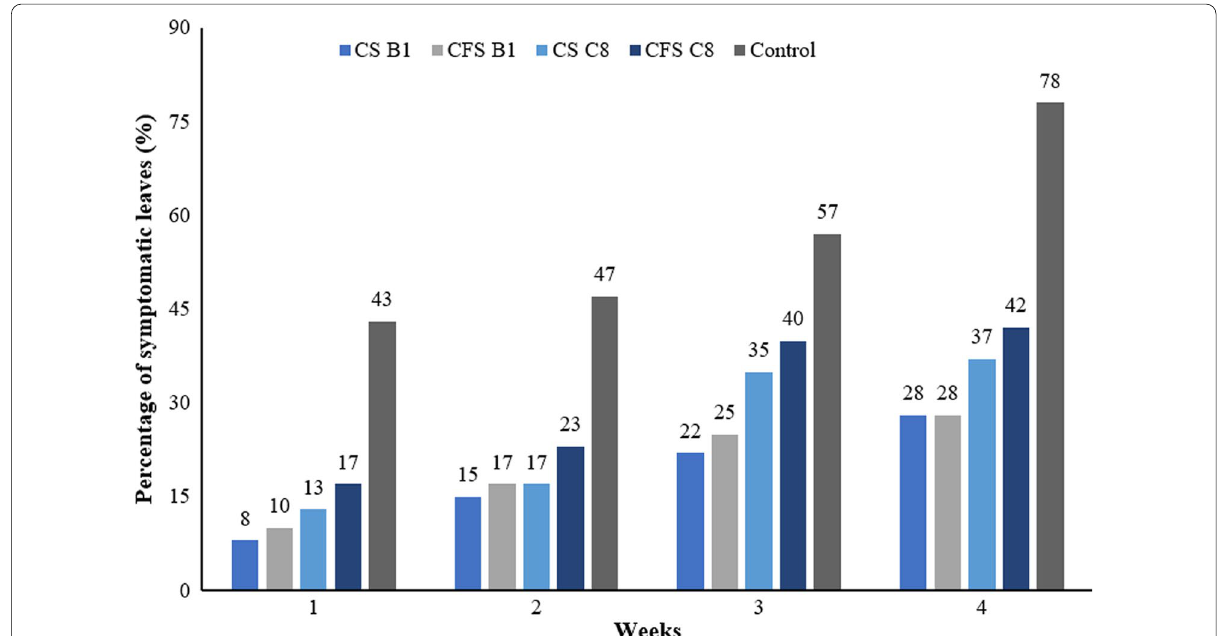
Fig. 7 Weekly citrus canker disease incidences of the treated leaves. Experiments were conducted in six plants with ten leaves in each plant. Data in this assay were expressed in percentages representing the total of symptomatic leaves over the total selected leaves in each group